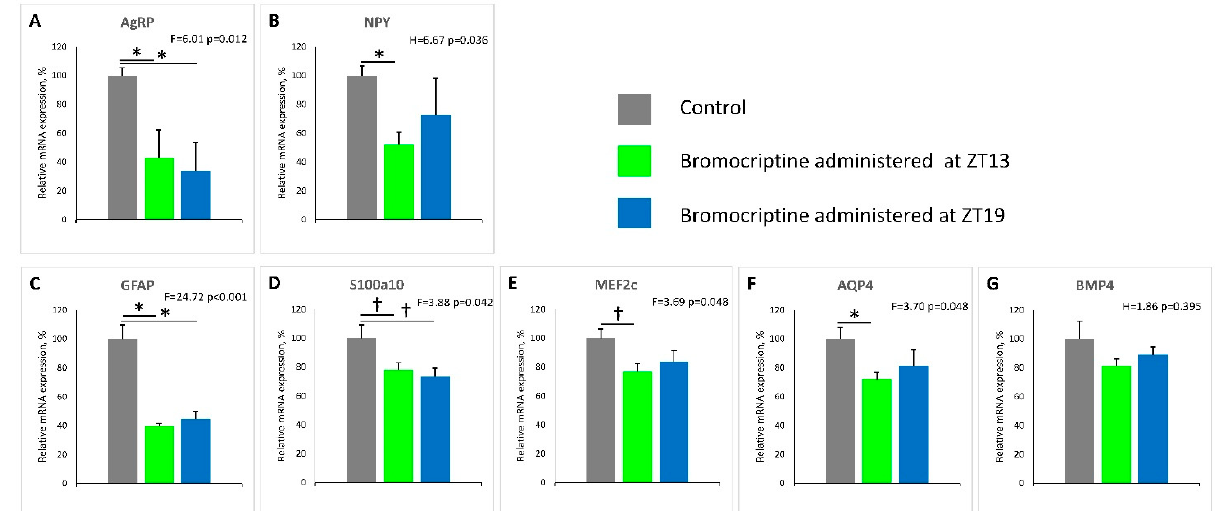
Figure 3. Impact of timed daily bromocriptine (at ZT 13 or ZT 19) or control treatment for 16 days on mediobasal hypothalamic (MBH) gene expression. Effects were examined using 1-way ANOVA (F) followed by pairwise post hoc (Holm–Sidak method) for normally distributed data, or Kruskal–Wallis (H) one-way analysis of variance on ranks test followed by Dunn’s pairwise multiple comparison procedures test for non-normal data, see Methods. The significant pairwise comparisons revealed from post hoc analysis or Dunn’s test are indicated by horizontal bars with *— p < 0.05, 2-sided; †— p < 0.05, 1-sided (see results for details of individual parameter comparison p values).